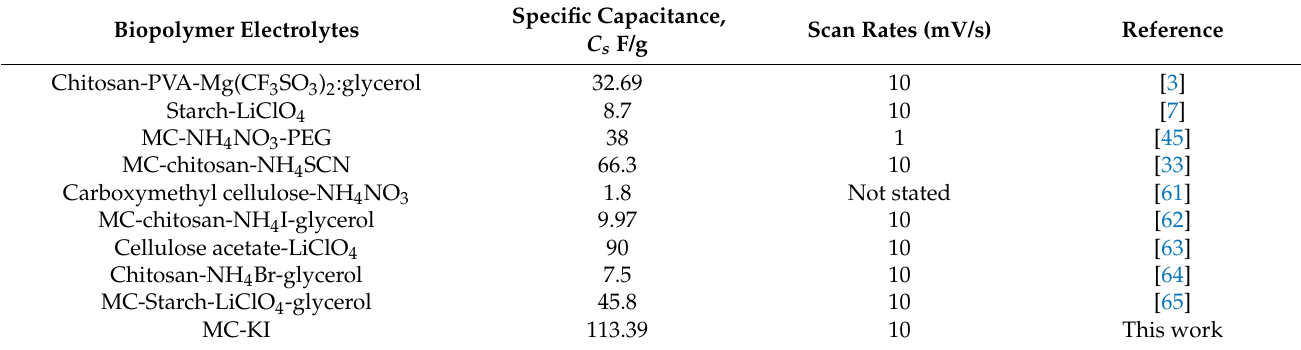
Table 4. Specific capacitance ( C s ) of the EDLCs using different polymer electrolytes at room temperature. Biopolymer